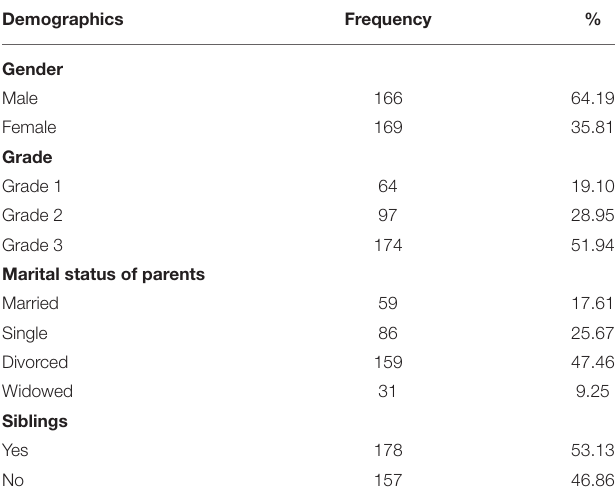
TABLE 1 | Demographic